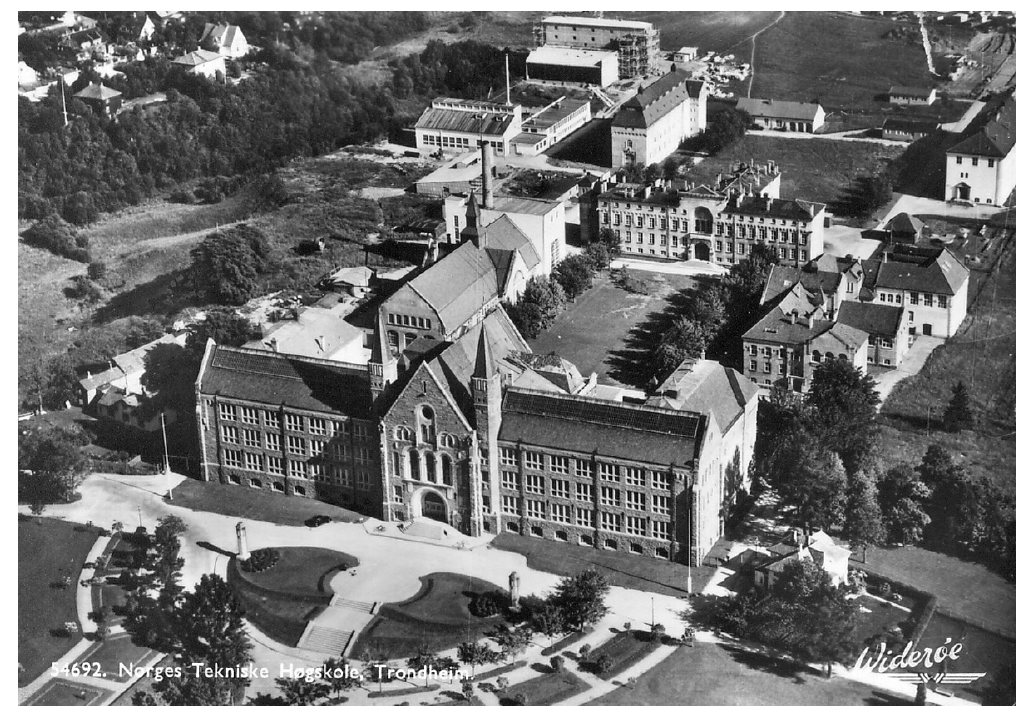
Figure 3: The campus of the Norwegian Institute of Technology in the